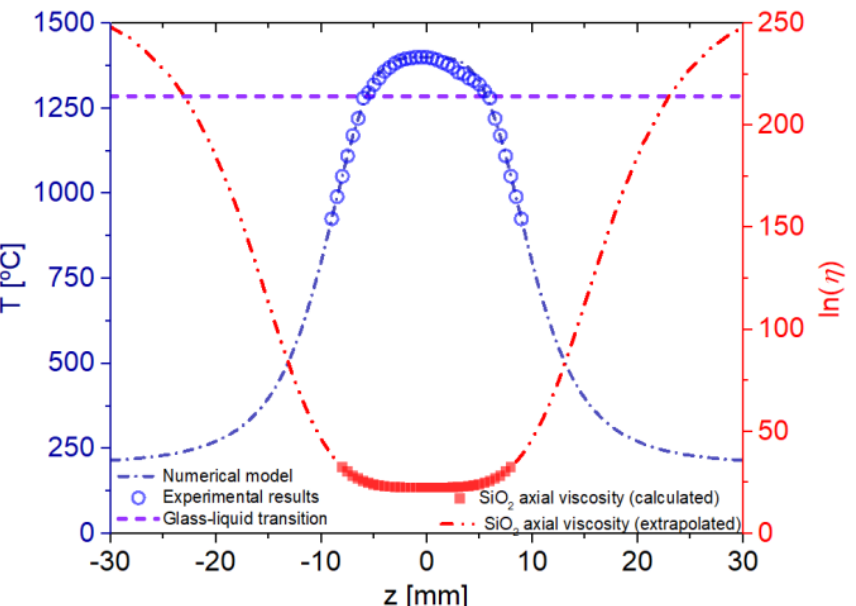
Figure 3. Experimental and modeled temperature curves of the graphite tube (heating element). The SiO 2 glass liquid transition temperature is shown in (dash line). Axial viscosity of the fiber material is shown in squares (red color). Below 1000 °C, extrapolation follows the temperature curve model of the graphite element.